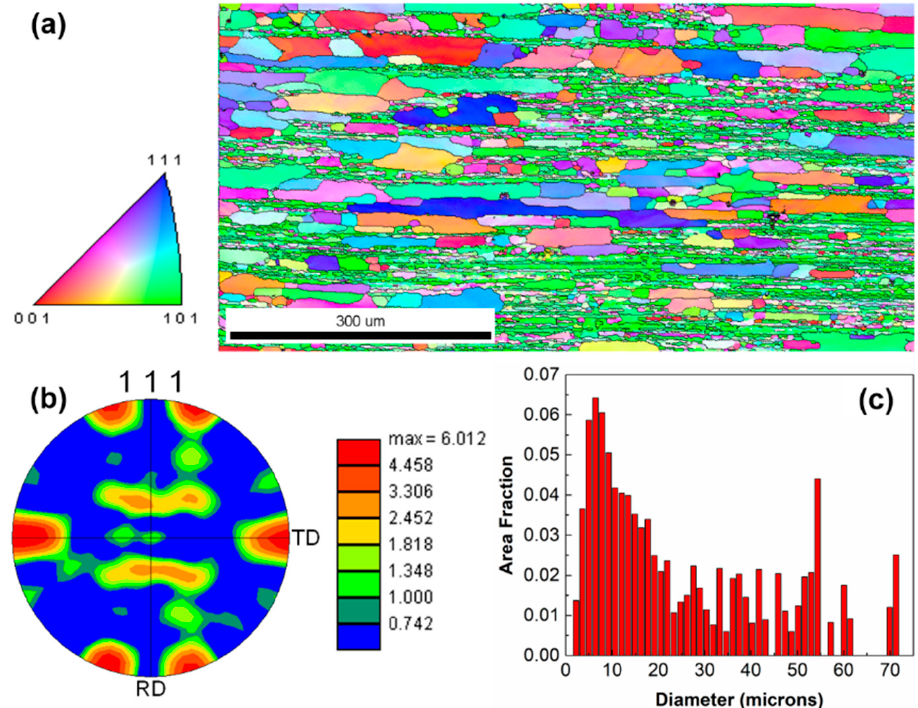
Figure 2. ( a ) An EBSD orientation map showing grain structure in the Al-Cu-Li-Mg-Zr alloys added with a low level of Fe content. ( b ) A <111> pole figure showing the distribution of crystal orientation. ( c ) A graph showing the size distribution of grains.